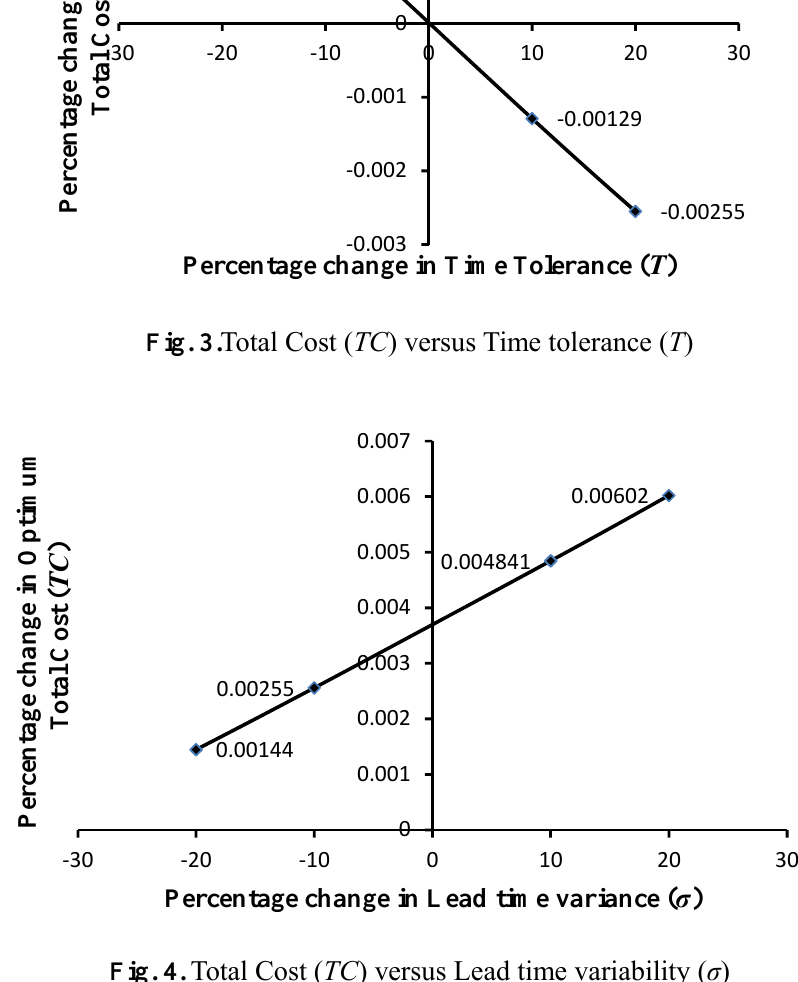
Fig. 4. Total Cost ( TC ) versus Lead time variability ( σ